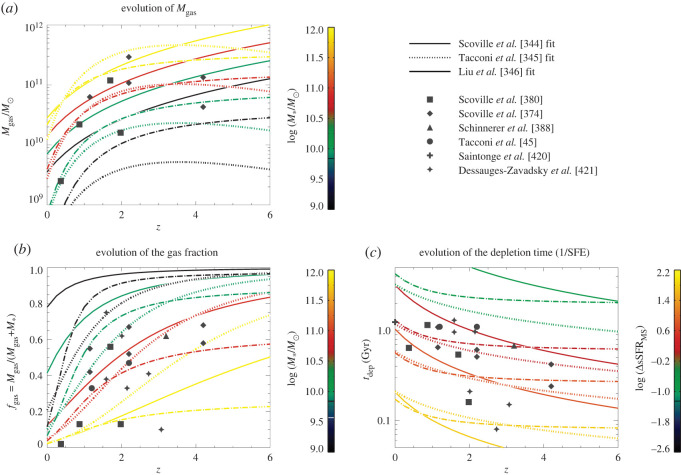
Scaling relations between star formation rate, stellar mass, gas content and redshift derived by Scoville et al. [344] (solid lines), Tacconi et al. [345] (dotted lines) and Liu et al. [346] (dotted-dashed lines). Here we focus in particular on the redshift evolution of the gas content (via the gas mass in (a) and the gas fraction in (b)) and depletion time (c), and colour-code the lines according to the main secondary property they depend on (stellar mass or distance from the main sequence). The small symbols show the measurements compiled and ‘benchmarked’ by Tacconi et al. [345]: circles show stacked measurements (mostly using dust continuum) and crosses show individual measurements. Larger symbols show additional notable individual results from the literature: Scoville et al. [380]: stack measurements based on ALMA continuum of 107 stellar-mass selected COSMOS galaxies at 0.2 < z < 2.5 with M∗∼1011M⊙; Scoville et al. [374]: stack measurements based on ALMA continuum of 145 star-forming galaxies at 〈z〉 = 1.1, 2.2 and 4.4, with M∗≳2×1010M⊙, with sources both on and above the main sequence; Schinnerer et al. [388]: individual ALMA continuum measurements of 45 main sequence galaxies at z ∼ 3.2 in the COSMOS field with M∗∼5×1010M⊙; Tacconi et al. [45]: IRAM PHIBSS CO(3-2) detections of 52 main sequence galaxies at z ≃ 1.2 and z ≃ 2.2 and M∗≳2.5×1010M⊙; Saintonge et al. [420]: 222 CO(1–0) measurements of z ∼ 0 galaxies with M∗≥2.5×1010M⊙ from the IRAM COLD GASS survey; Dessauges-Zavadsky et al. [421]: IRAM CO measurements of five z ∼ 1.5 − 3 lensed galaxies with low stellar masses (M∗<2.5×1010M⊙) and low star formation rates (SFR<40M⊙ yr−1).